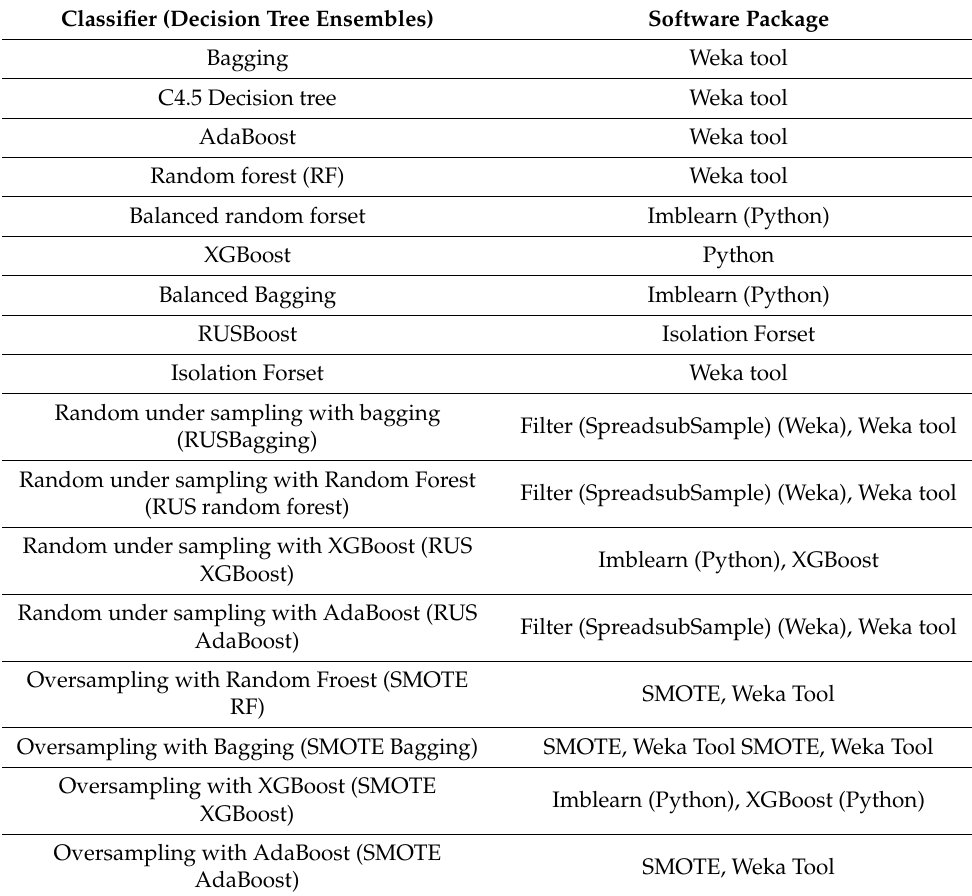
Table 2. Experimental setup using packages and